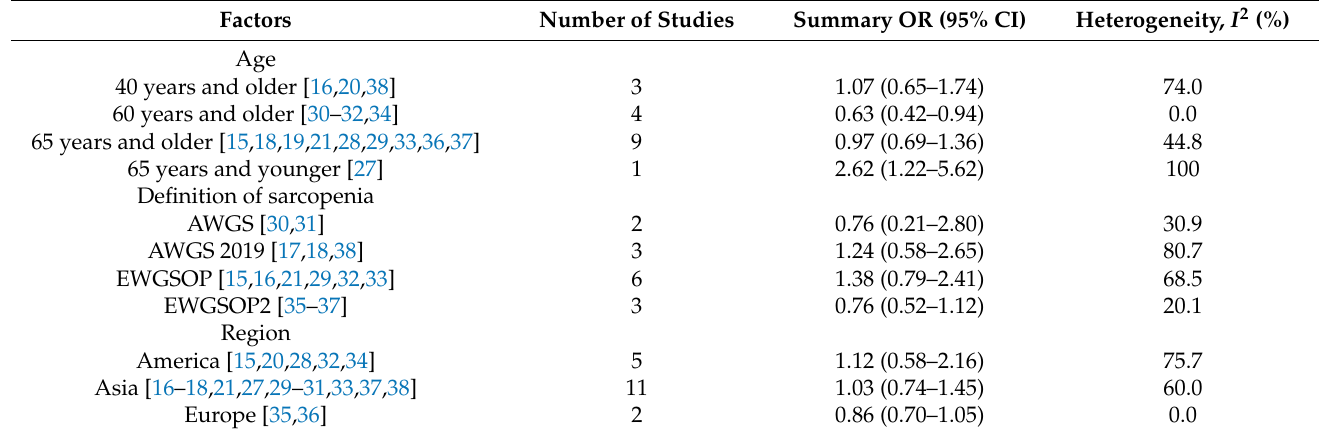
Table 3. Subgroup meta-analyses in relation to sarcopenia and alcohol